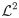
Diffusivity equation—inverse modeling: PINN performance as function of training set size.This figure shows the estimated error dependency on the amount of training data, Ntr. The error bars show mean and standard derivation (± 1 SD) based on 24 realizations. Note that there is no noise added in this investigation, and all physical constants are set to one, i.e., θ1 = θ2 = 1.0. The reported error values of θ1 and θ2 are percentage errors while the relative L2 error is shown for p.